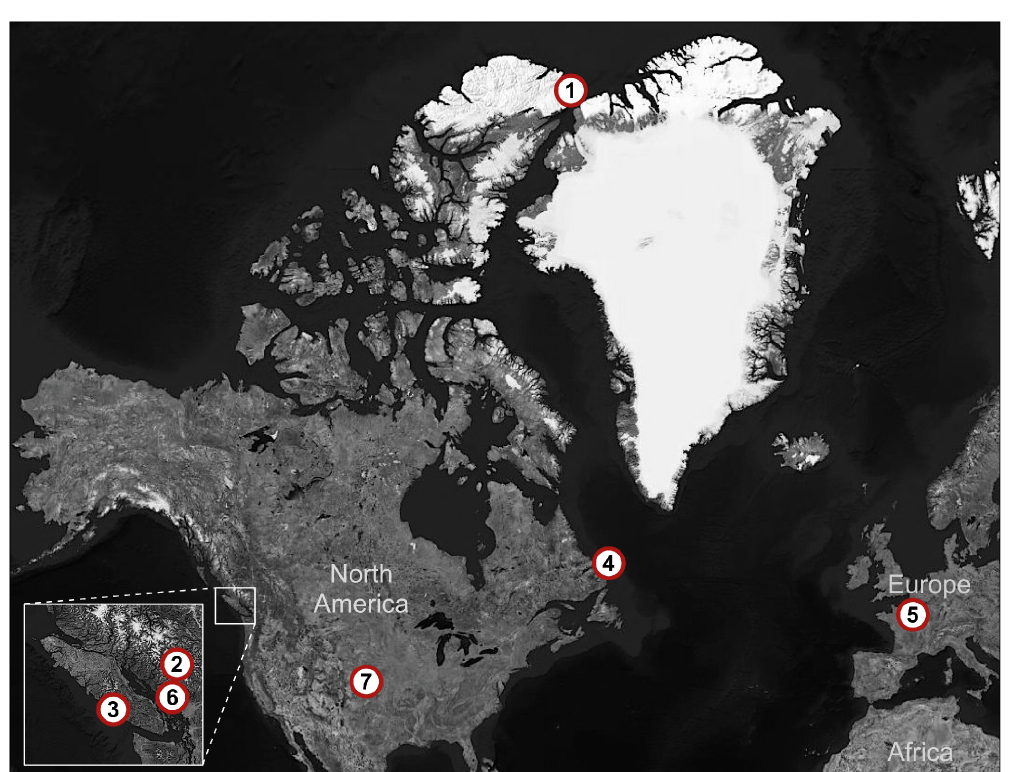
Figure 1. Sampling locations used in this study: (1) Alert, Nunavut, Canada; (2) Whistler Mountain, British Columbia, Canada; (3) Am- phitrite Point, British Columbia, Canada; (4) the Labrador Sea, Canada; (5) CEA in Saclay, France; (6) the University of British Columbia campus, British Columbia, Canada; and (7) Colby, Kansas, USA. Site coordinates are given in Table 1 with details in Sect. 2.1. The image was modified from Bing Maps, 2014